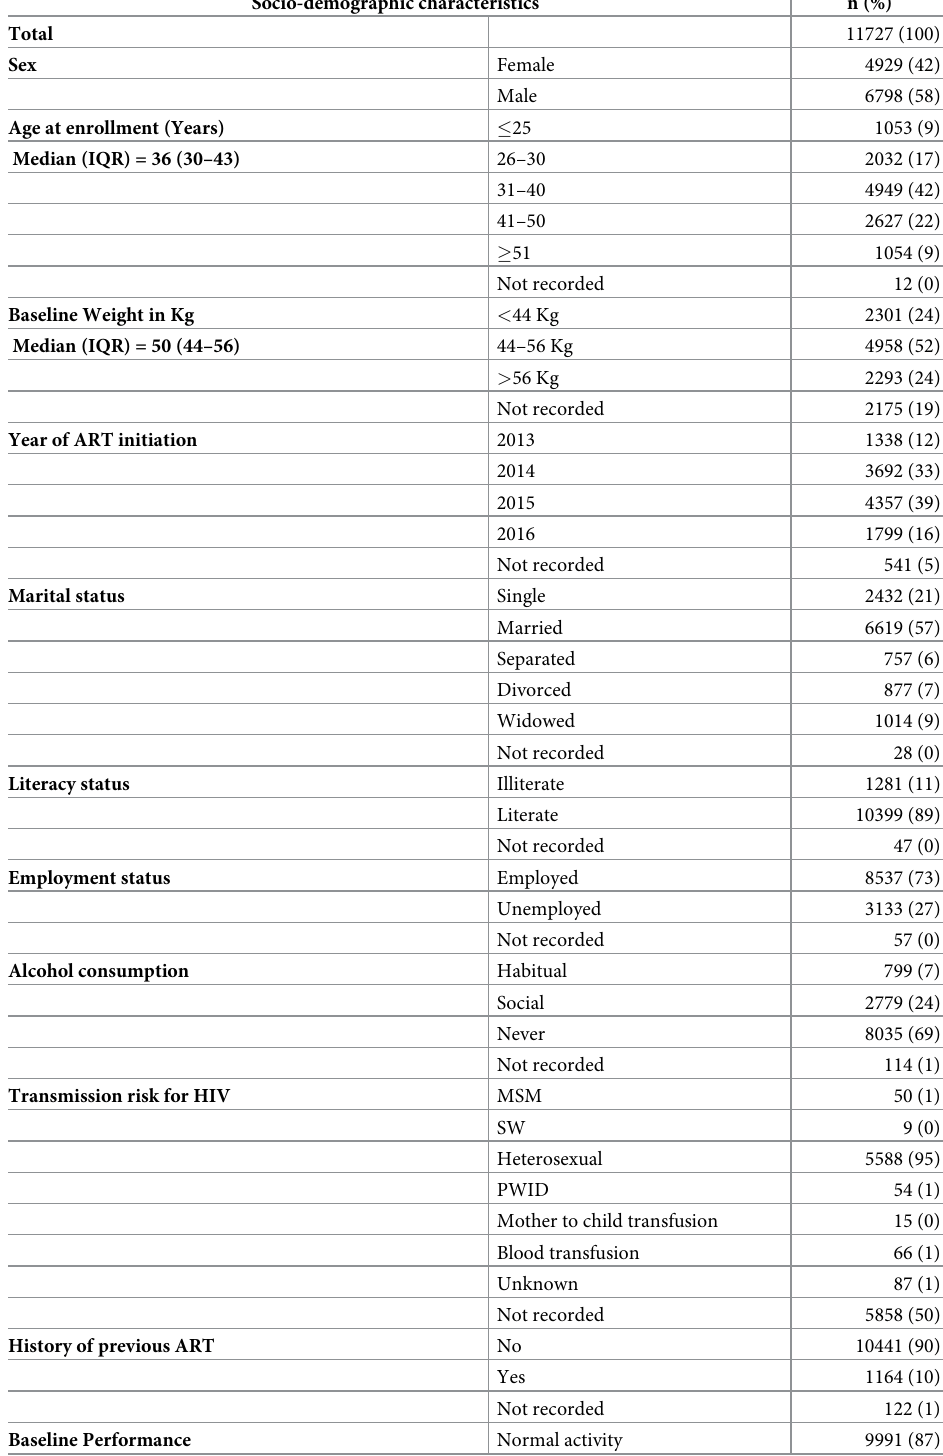
Table 1. Socio-demographic, clinical and immunological characteristics of adult people living with HIV who were enrolled in three hospitals specializing for HIV care in Yangon, Myanmar, 1st June 2013 to 30th June